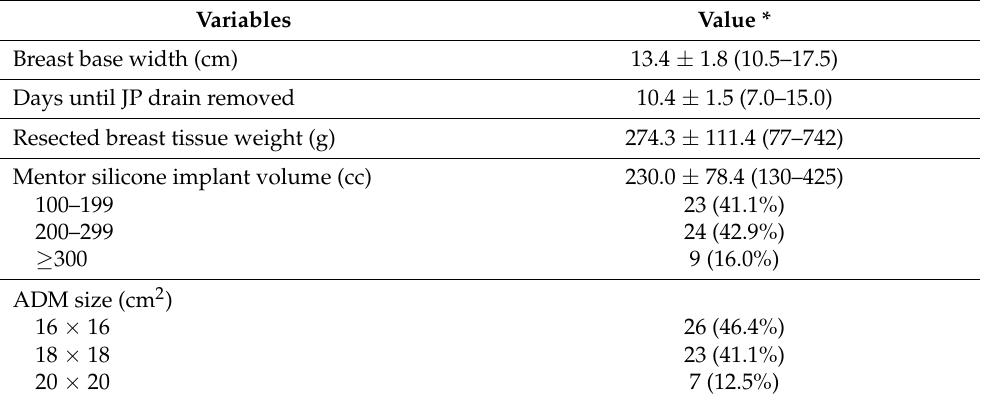
Table 2. Patients’ reconstruction